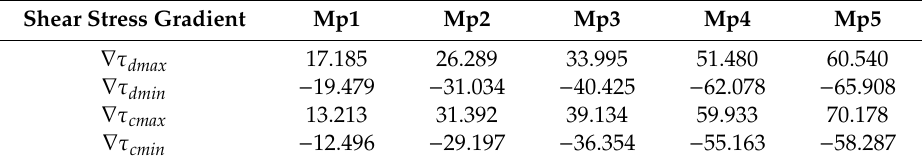
Table 4. Shear stresses gradient under microbes for microstructural surfaces in three periods. Shear Stress Gradient